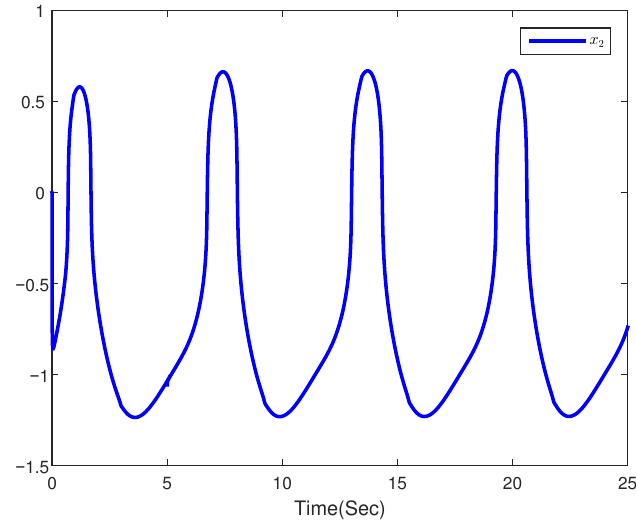
Figure 10. The system state x 2 (Case